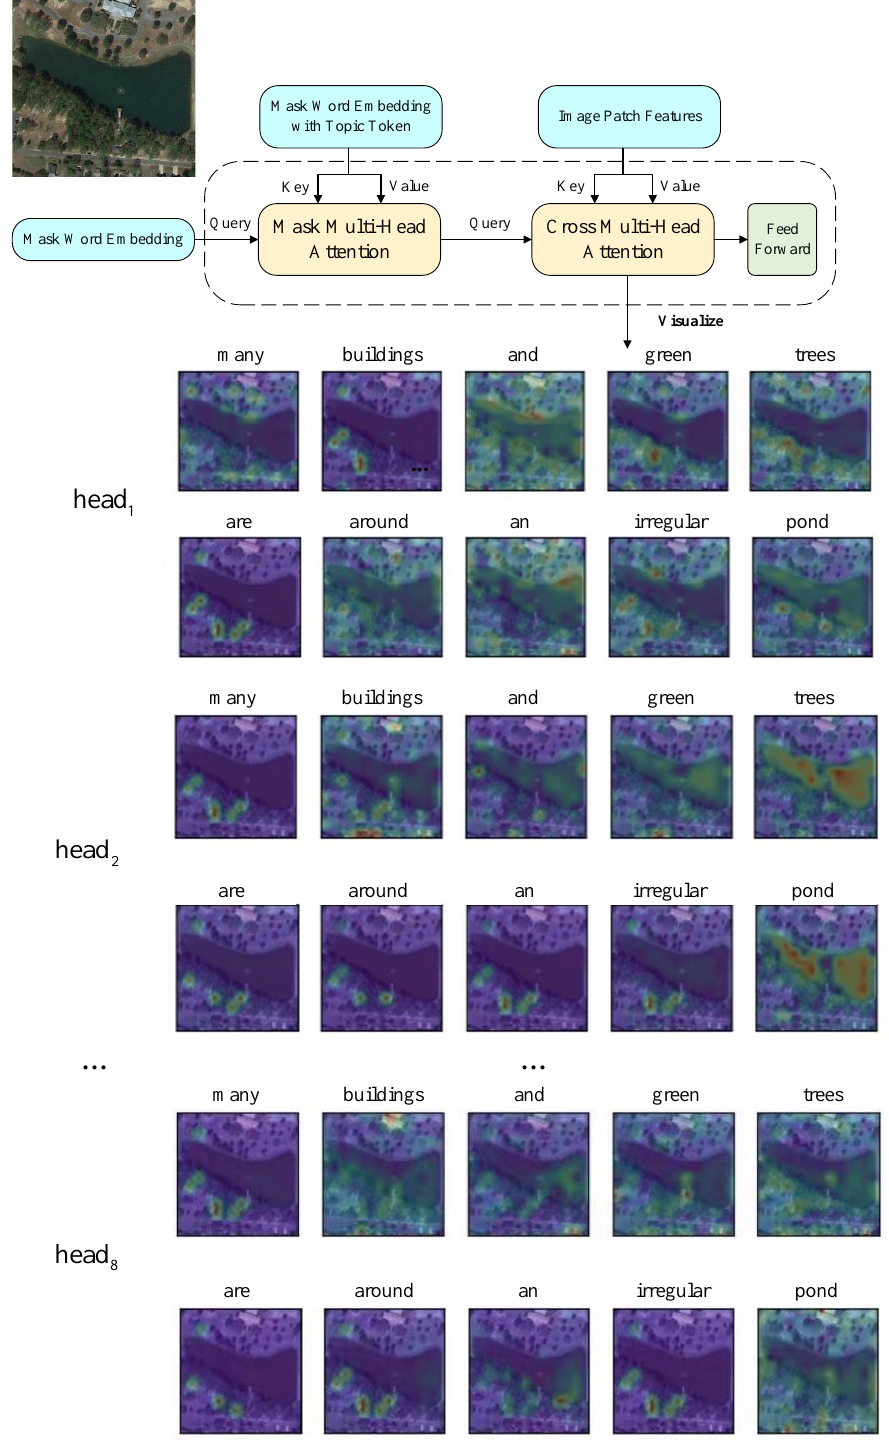
Figure 9. Visualization of cross-modal multi-head attention in